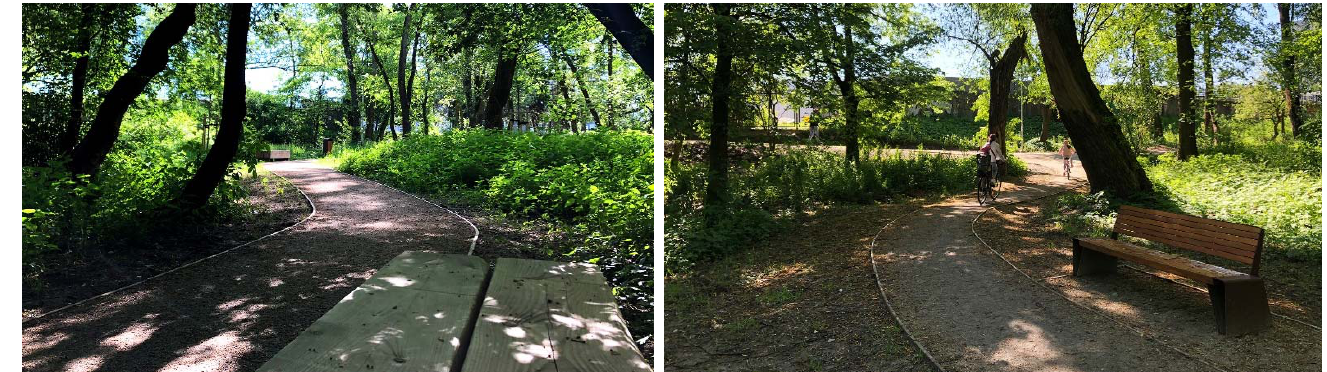
Figure 10. Wilga Park, Kraków, designer: Gajda Architektura Krajobrazu (Photos by A. Rejman, 2021).